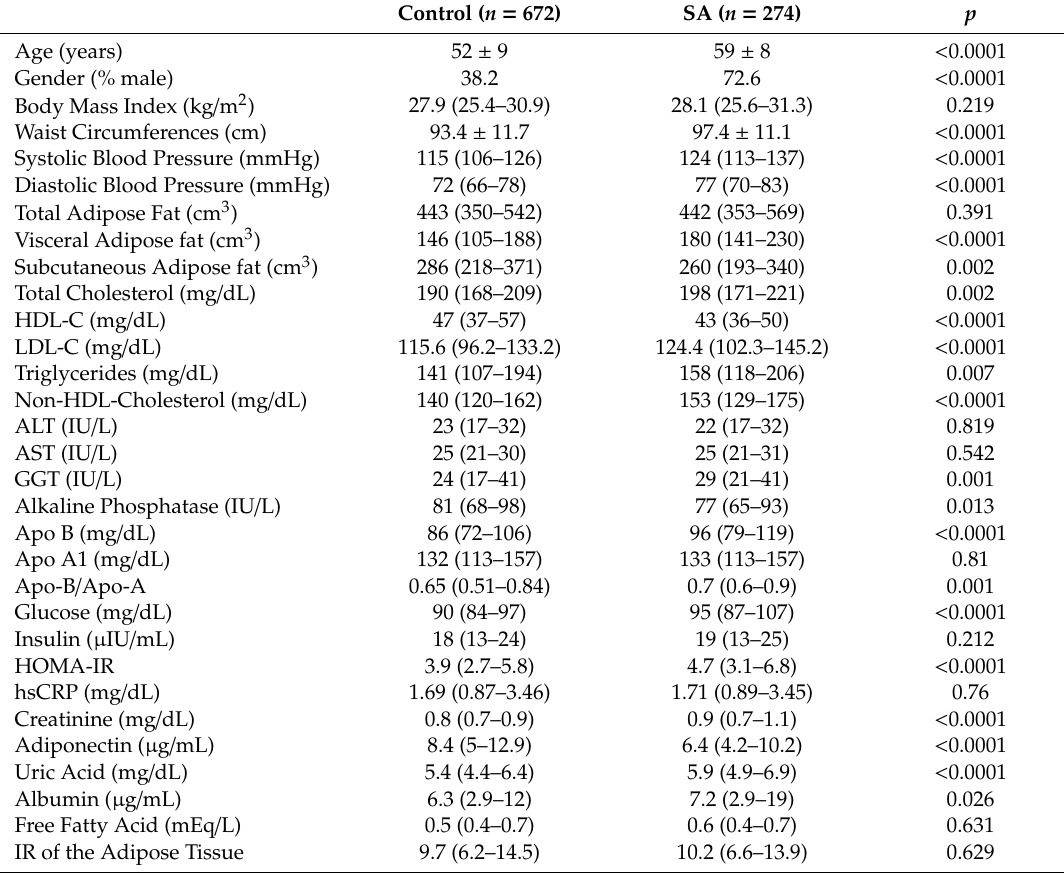
Table 1. Clinical and metabolic characteristics of the studied